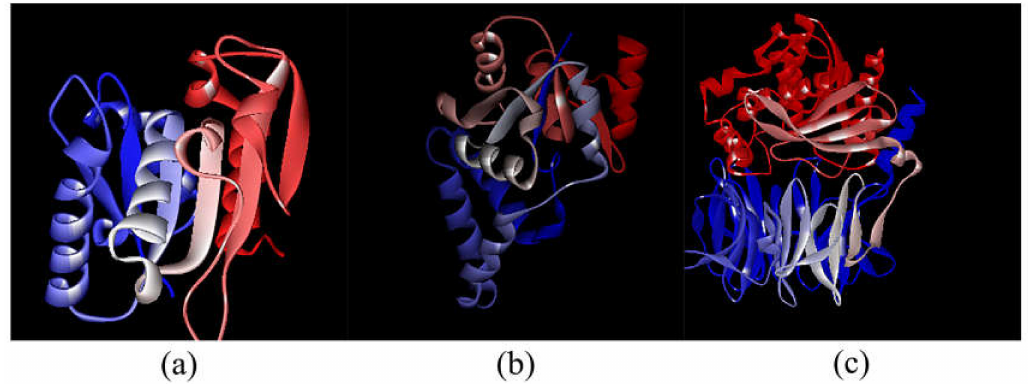
Figure 2. The structure of model enzyme. ( a ) The structure of ST2570 (PDB:2W43); ( b ) the structure of BsLA (PDB:1I6W); ( c ) the structure of APE1547 (PDB:1VE6). The red is the N-terminal and the blue is the